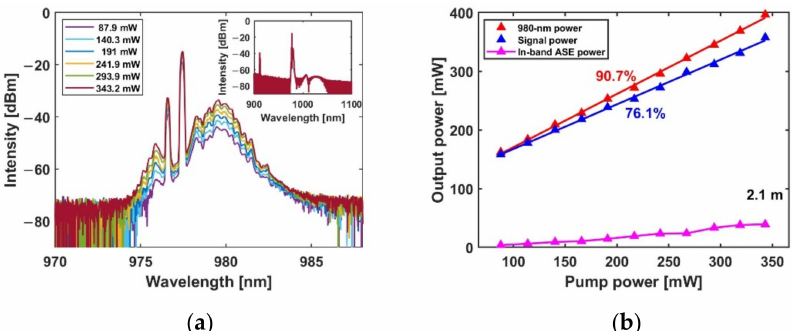
Figure 12. ( a ) The variation of output spectra with pump power. ( b ) The variation of output power with pump power by using the double-wavelength seed